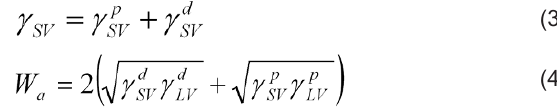
Table 2. The ratio areas for the bonded carbonyl and c arbonyl (free + bonded carbonyl).